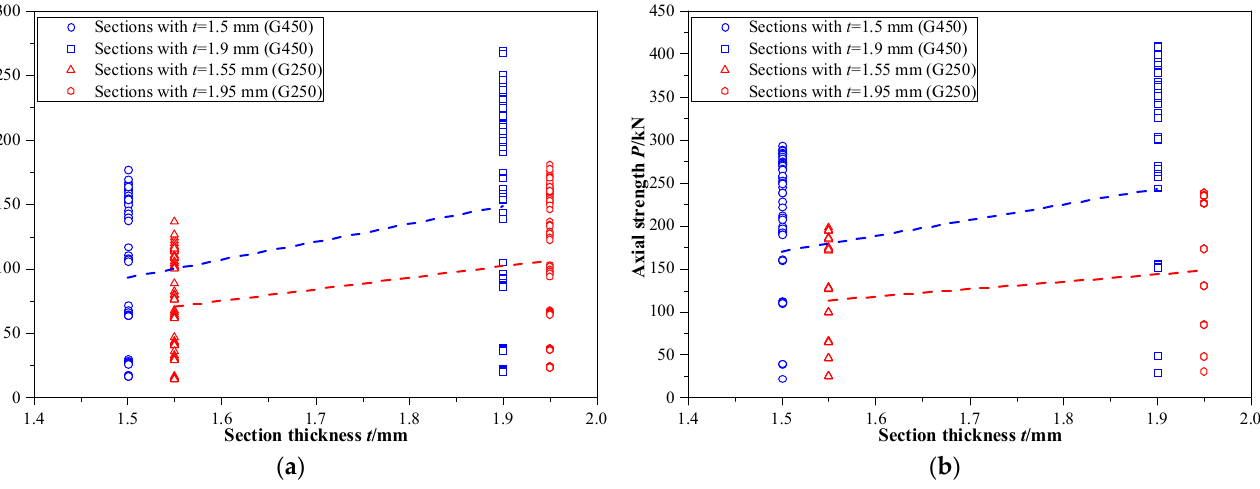
Figure 6. Influence of section thickness ( t ): ( a ) axial capacity of CFS-FTF built-up unlipped channel columns with different thicknesses; and ( b ) axial capacity of CFS-FTF built-up lipped channel columns with different thicknesses.